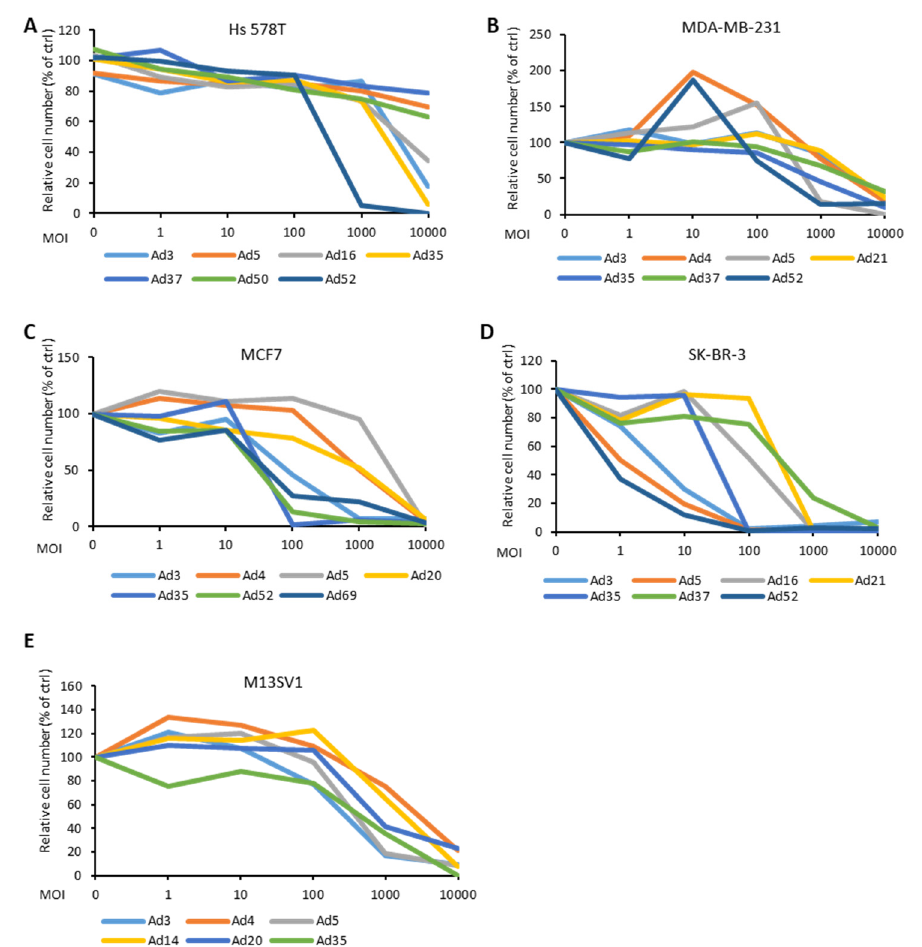
Figure 6. Cytotoxicity in response to infection with the different Ad types at various multiplicity of infection (MOI) (0, 1, 10, 100, 1000, and 10,000 virus particles per cell (vp/c)). Cell cytotoxicity was assessed by crystal violet staining (Figure S7) and then furthermore, quantified by measuring the absorbance of solubilized crystal violet dye at 570 nm. The data is displayed as percentage (%) of viable cells (i.e., stained cells) exposed to infection in relation to viable cells in the control (ctrl, uninfected) sample.